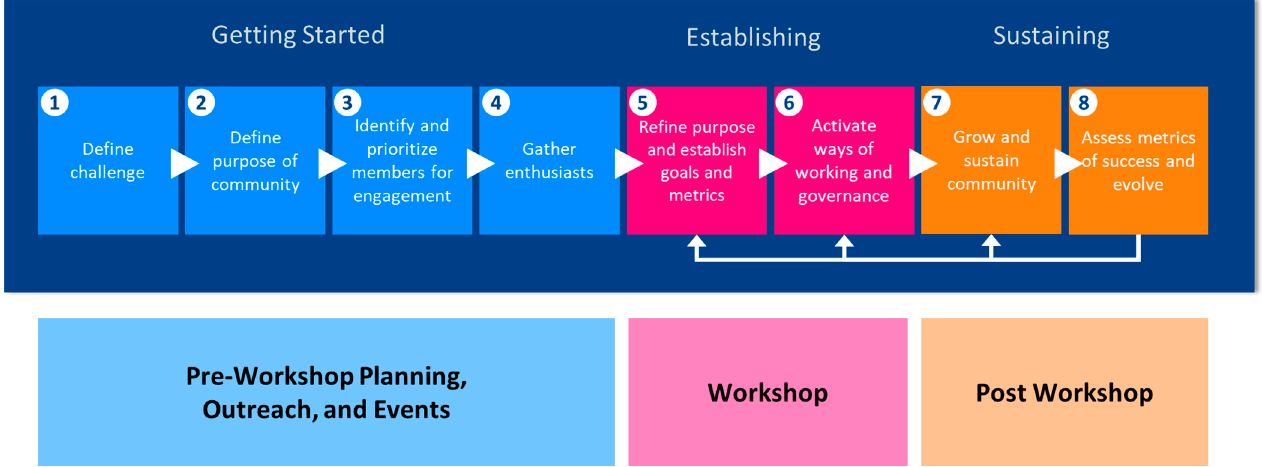
Figure 5. Components of building a community.